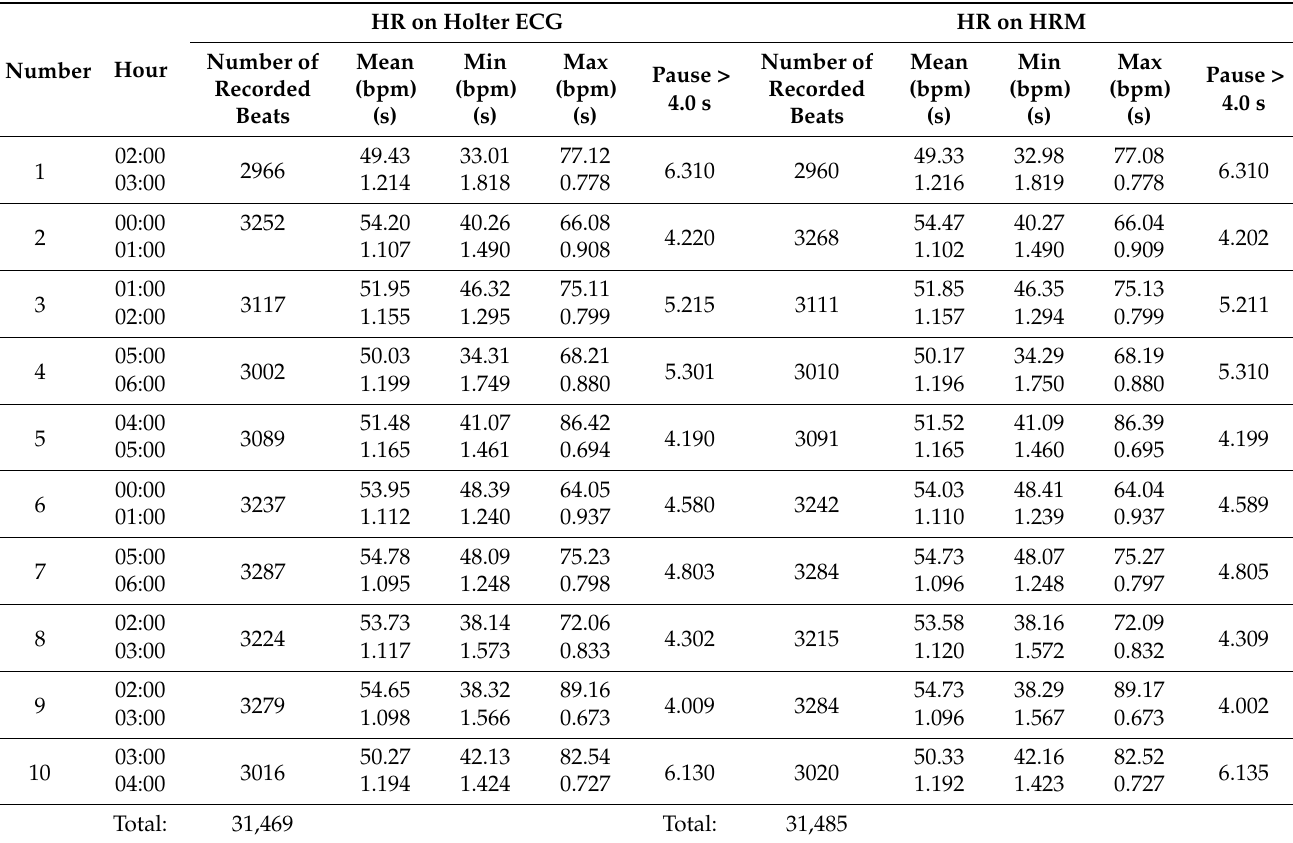
Table 2. Summary analysis of the recordings from the Holter ECG and